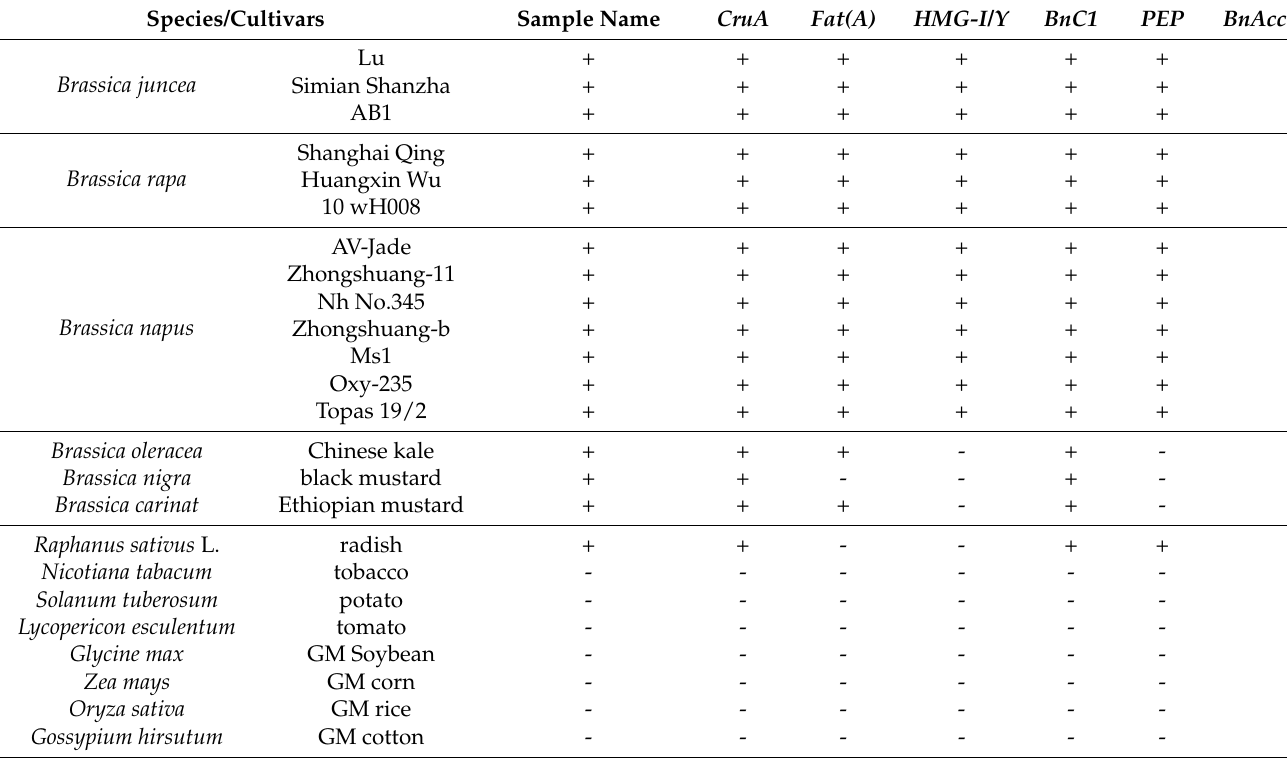
Table 2. Specificity analysis of the endogenous reference